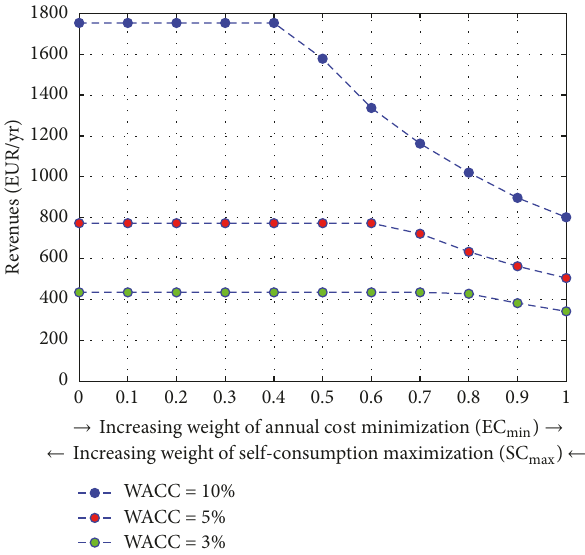
Figure 25: German retail electricity prices: annual electricity costs for the building considered as total